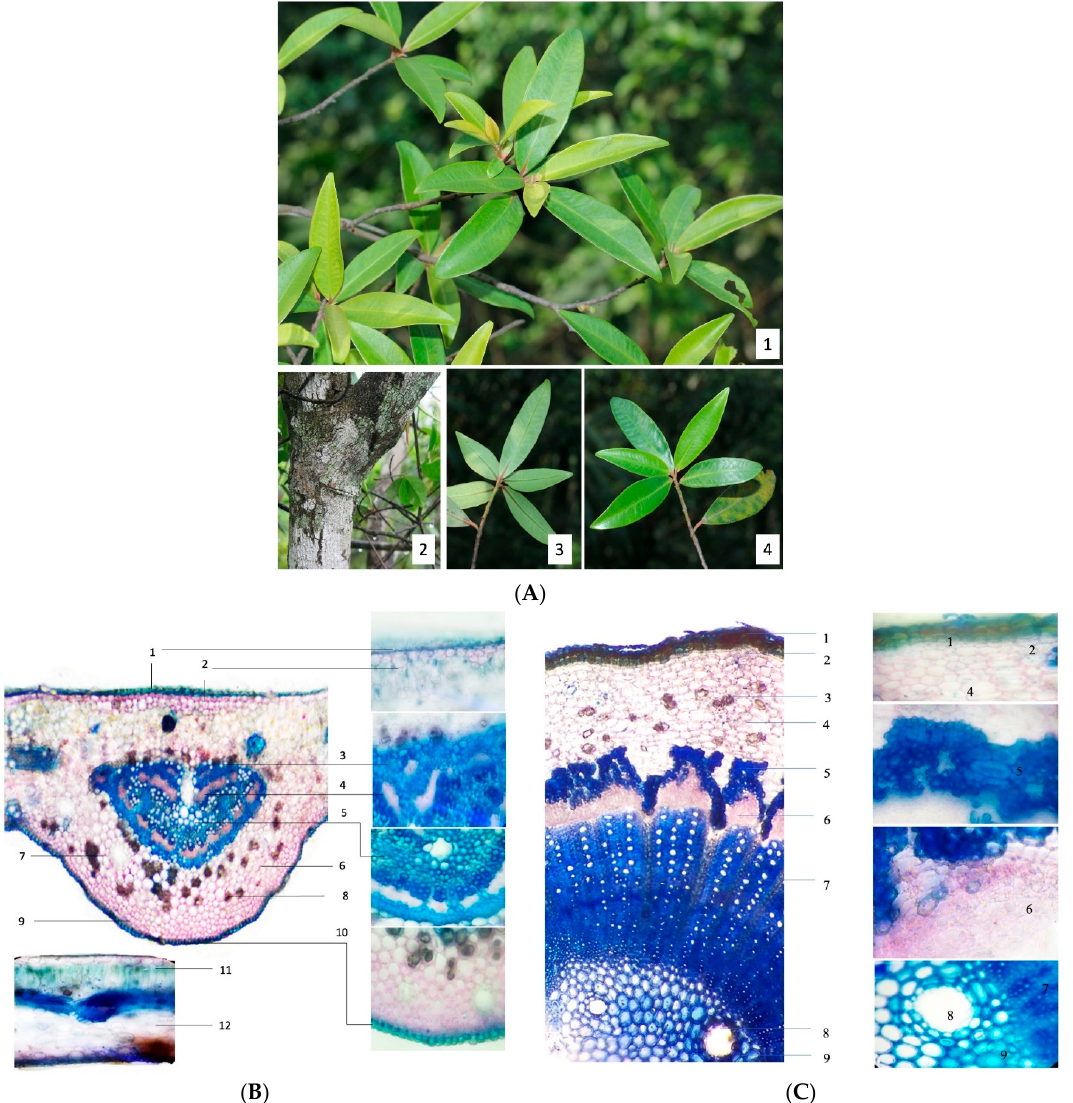
Figure 1. ( A ) Morphological characteristics of Myrsine seguinii H. L é v. (1) branchlets, (2) plant bark, (3) abaxial leaf, (4) adaxial leaf; ( B ) Cross-section of the leaf of M. seguinii . (1) upper epidermis, (2) upper collenchyma, (3) sclerencyma, (4) phloem, (5) xylem, (6) collenchymal tissues, (7) schizogenous cavity, (8) calcium oxalate crystals, (9) lower chollenchyma, (10) lower epidermis, (11) palisade mesophyll, (12) spongy mesophyll; ( C ) Cross-section of the stem of M. seguinii . (1) cork, (2) parenchyma cells, (3) calcium oxalate crystals, (4) parenchyma, (5) sclerenchyma cells, (6) secondary phloem, (7) secondary xylem, (8) schizogenous cavities, (9) primary